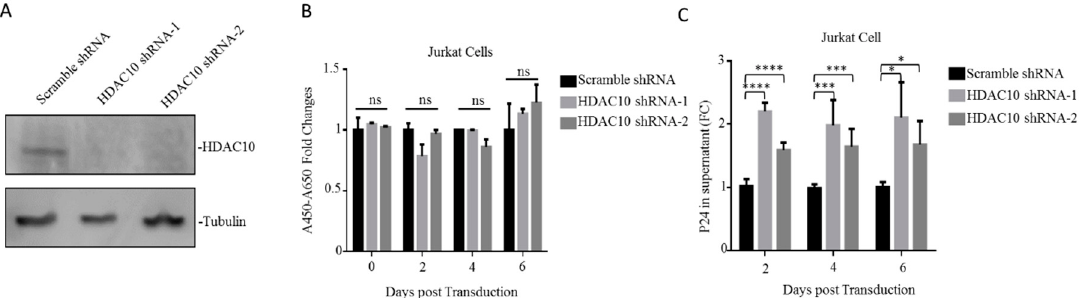
Figure 2. HDAC10 downregulation benefits HIV-1 replication. ( A ) The HDAC10 protein expression in HDAC10 shRNA-1, shRNA-2, and transduced cells or scramble shRNA transduced Jurkat cells. ( B ) The cell proliferation of HDAC10 shRNA or scramble shRNA transduced cells were detected by WST-1 assay on 2nd, 4th, and 6th day. ( C ) HDAC10 shRNA, or scramble shRNA transduced cells, were subjected to the infection by HIV-1 (N119) and the supernatants from infected cells were collected at indicated time point. The viral protein p24 in the supernatant was detected by anti-p24 ELISA. Data are mean and sd calculated from two duplicate samples. Ns, no significance; *, p < 0.05; ***, p < 0.005; ****, p < 0.001. (Two-tailed unpaired t -test).